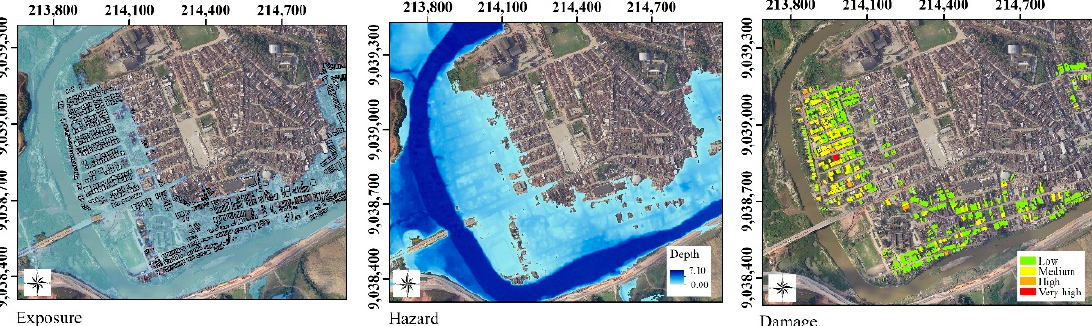
Figure 8. 200-year flood maps (with Serro Azul reservoir).